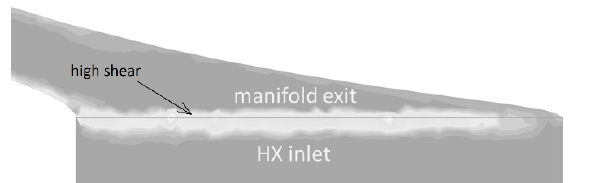
Figure 21. Extreme production of turbulence kinetic energy around the manifold-HX interface.